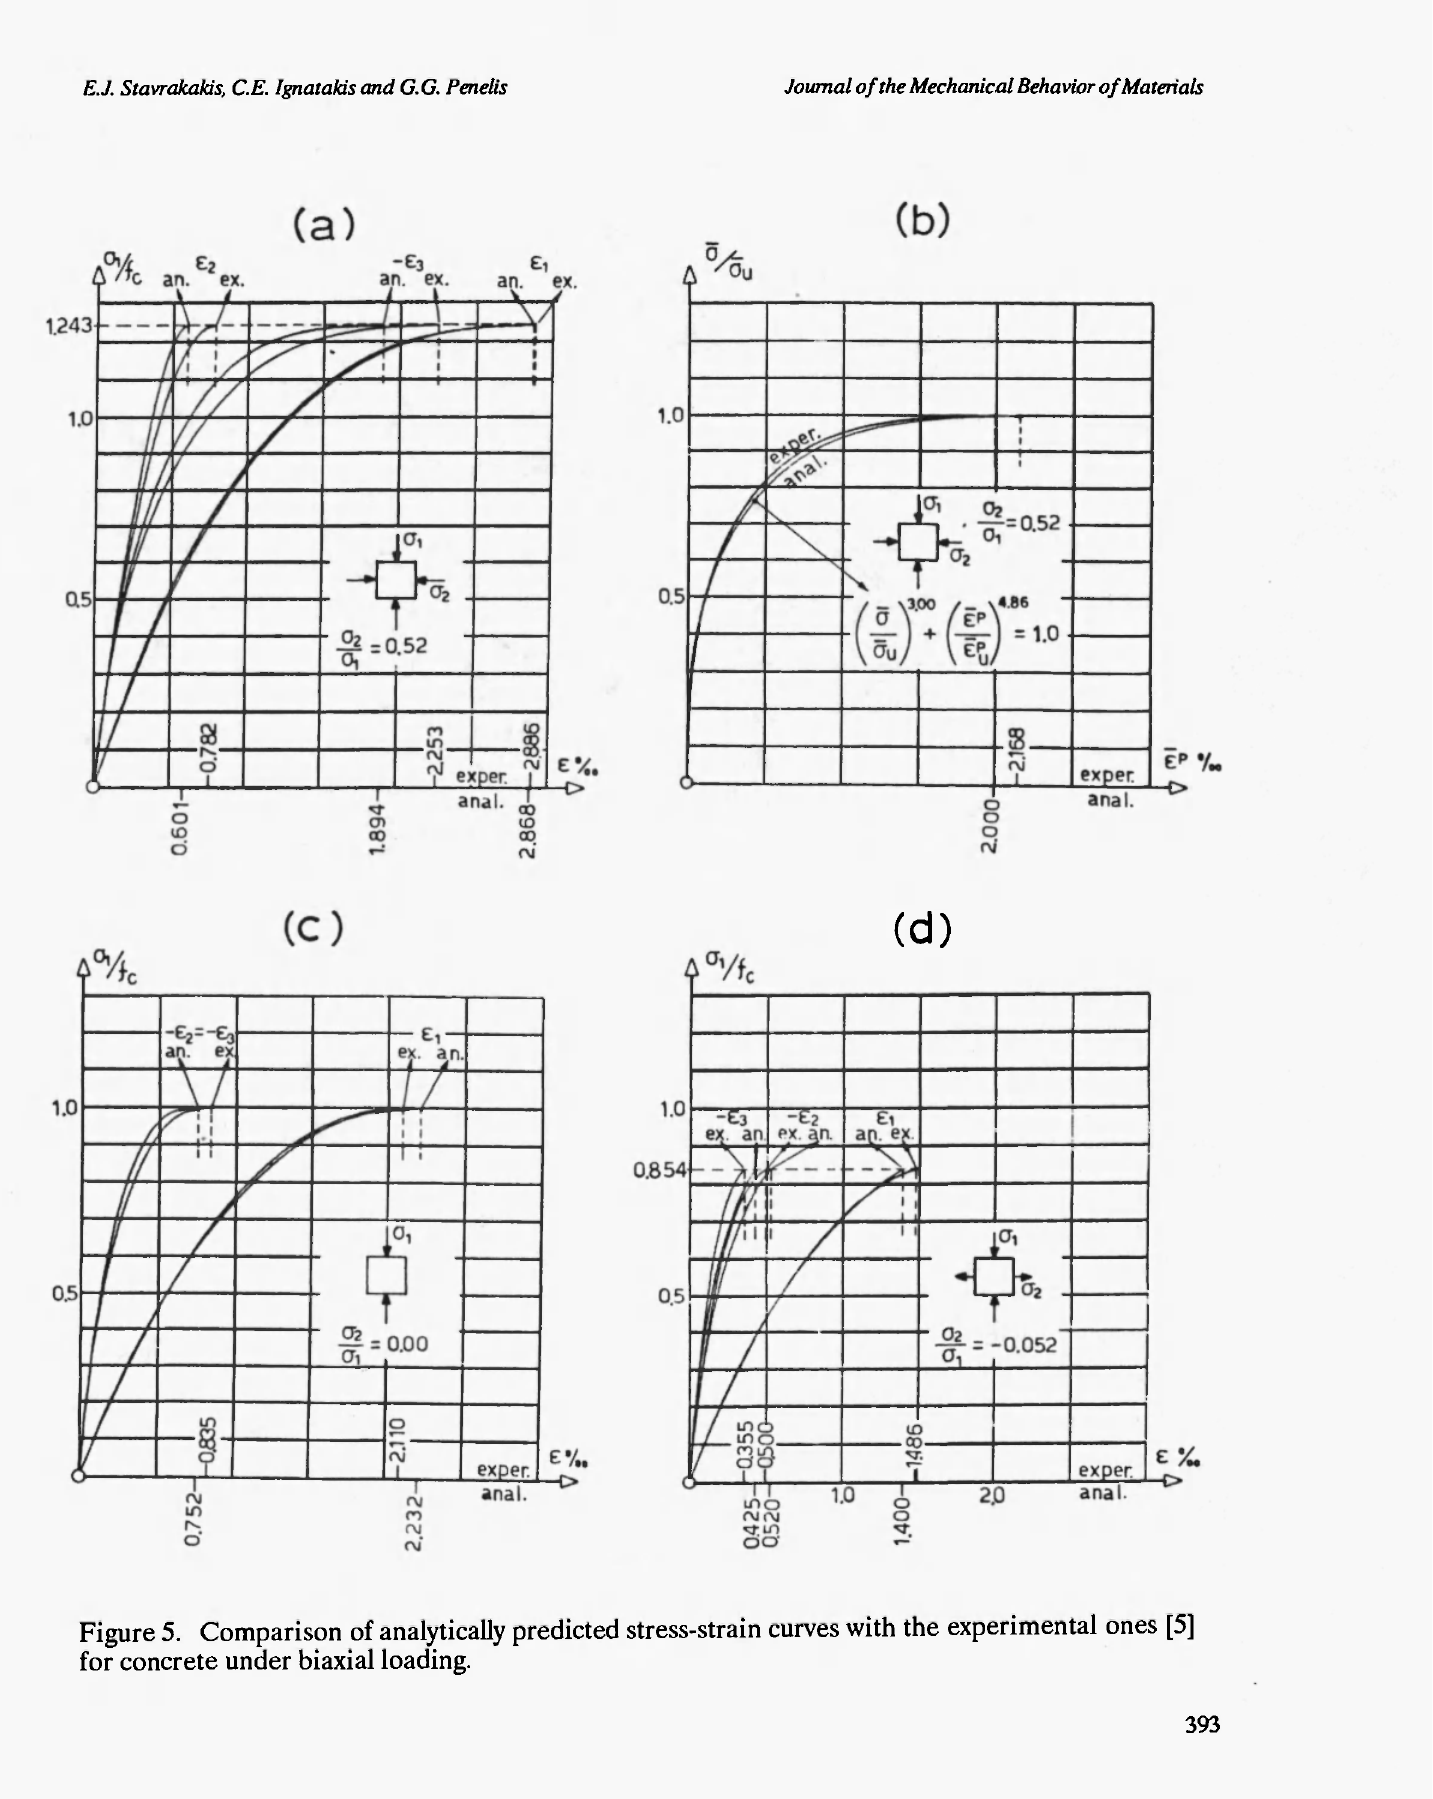
Figure 5. Comparison of analytically predicted stress-strain curves with the experimental ones [5] for concrete under biaxial